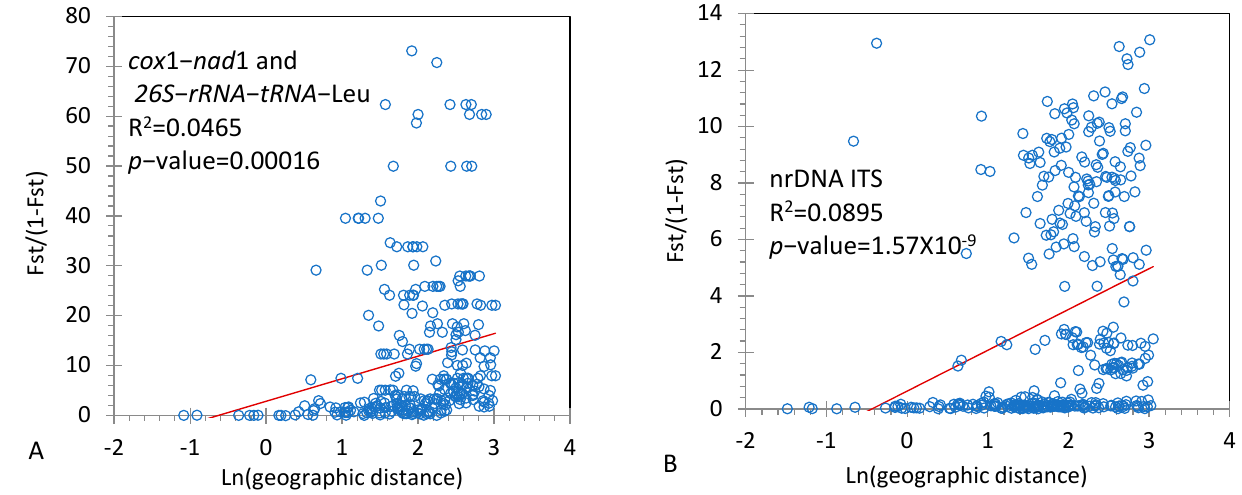
Figure 3. Effects of isolation by distance (IBD) among range-wide populations of T. ciliata complex. ( A ). Results from the concatenated sequences of cox1 − nad 1 and 26S − rRNA − tRNA − Leu from mitochondrial genome; ( B ). Results from nrDNA ITS sequences.